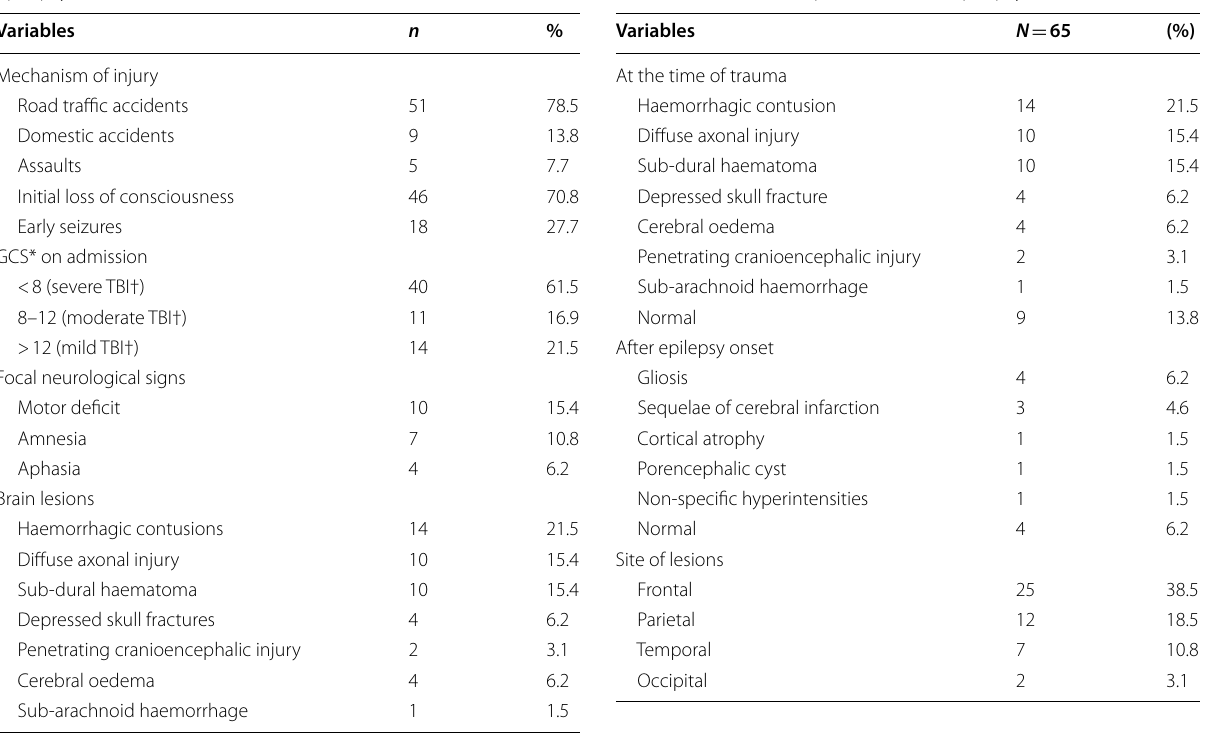
Table 4 Neuroimaging findings after the traumatic brain injury